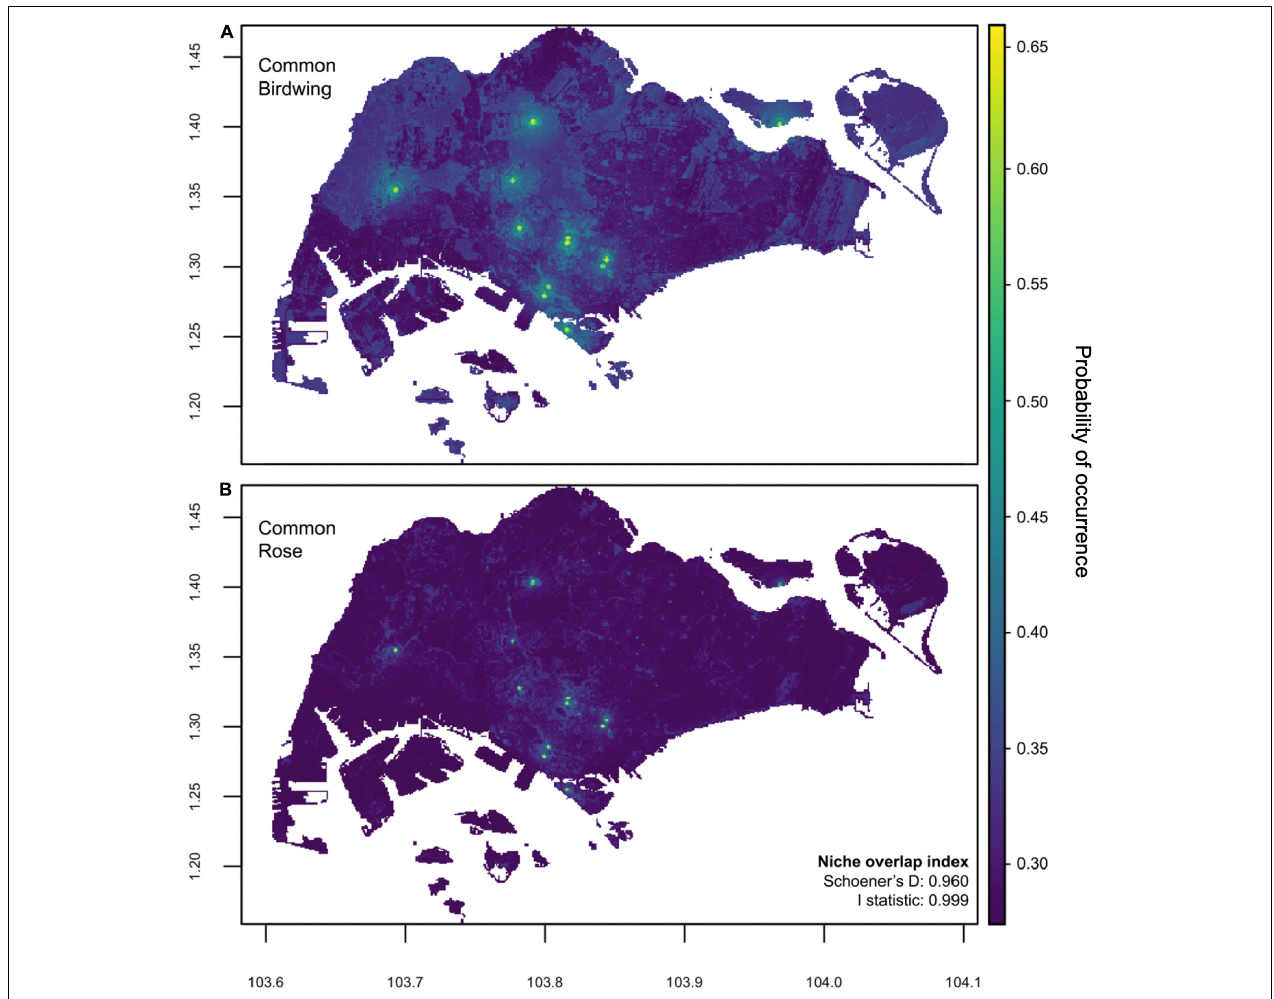
FIGURE 2 | Prediction maps showing the probability of occurrence of (A) BW and (B) CR butterfly species in Singapore. Both species possess similar predicted occurrence patterns and possess a relatively high degree of spatial overlap, as indicated by the Schoener’s D and I-statistic. The latitude and longitude values are shown on the vertical and horizontal axis,